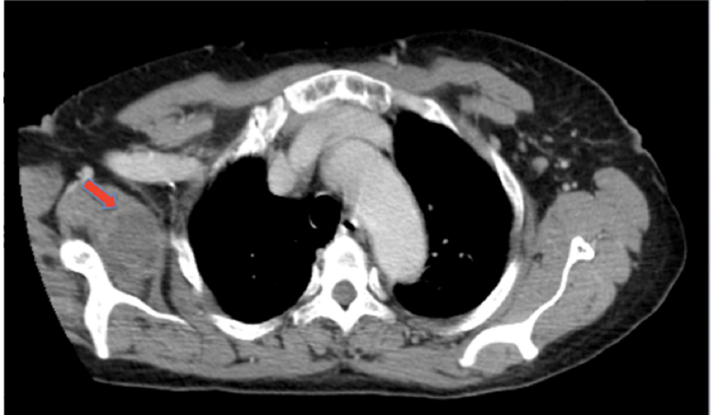
Figure 2. CT scan: density alteration of the right scapula and infiltrative involvement of subscapularis muscle.